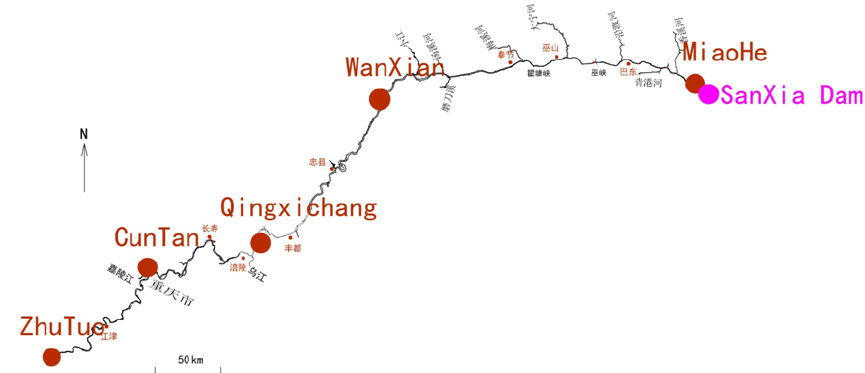
Figure 1. Study scope of the Three Gorges reservoir area.